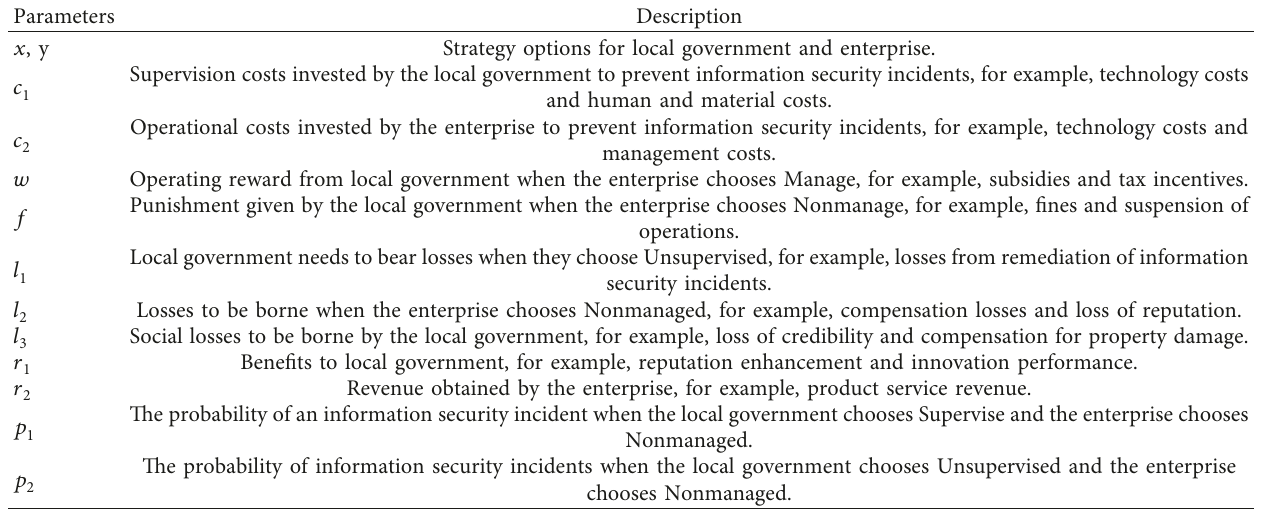
Table 1: Parameter definition.